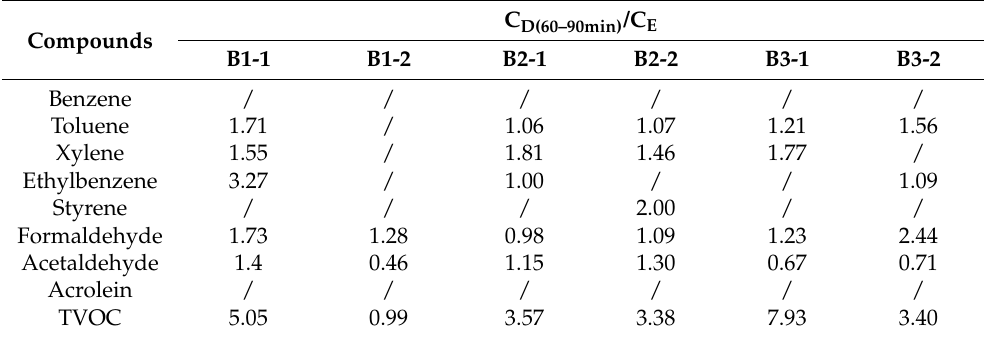
Table 3. The ratios of C D(60–90min) and C E of eight confirmed compounds and TVOC measured inside Brand B.